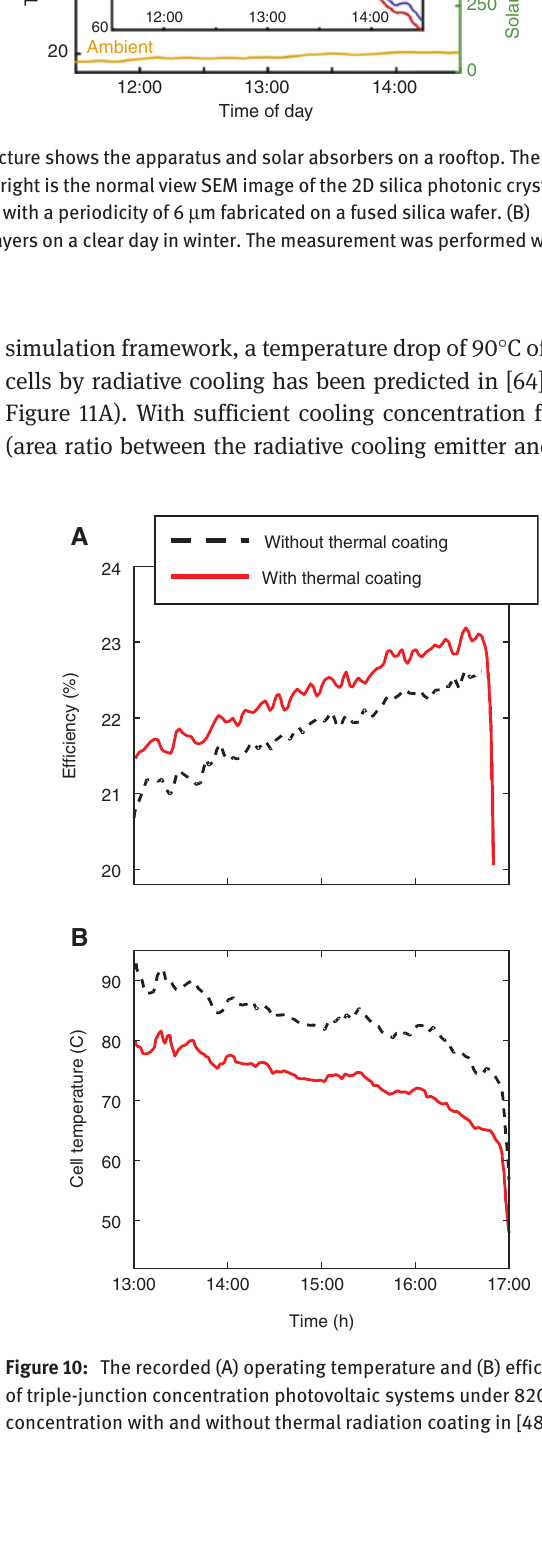
Figure 10: The recorded (A) operating temperature and (B) efficiency of triple-junction concentration photovoltaic systems under 820 suns concentration with and without thermal radiation coating in